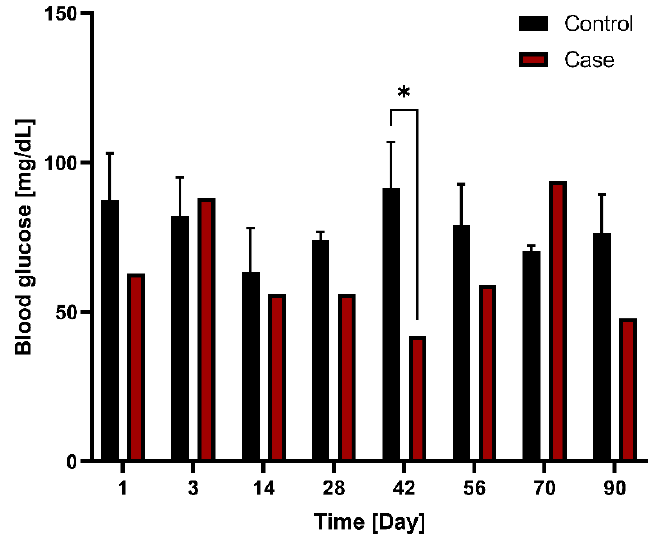
Figure 6. Comparison of blood glucose levels between the control ( n = 3) and case ( n = 1) groups with G-DFR placement based on observation periods. A significant difference (*, p < 0.05) was observed in the blood glucose levels between control (91 mg/dL) and case group (42 mg/dL) on day 42 ( p = 0.026). This trend was subsequently maintained at 90 days. G-DFR, Gastro-duodenal flow restrictor.